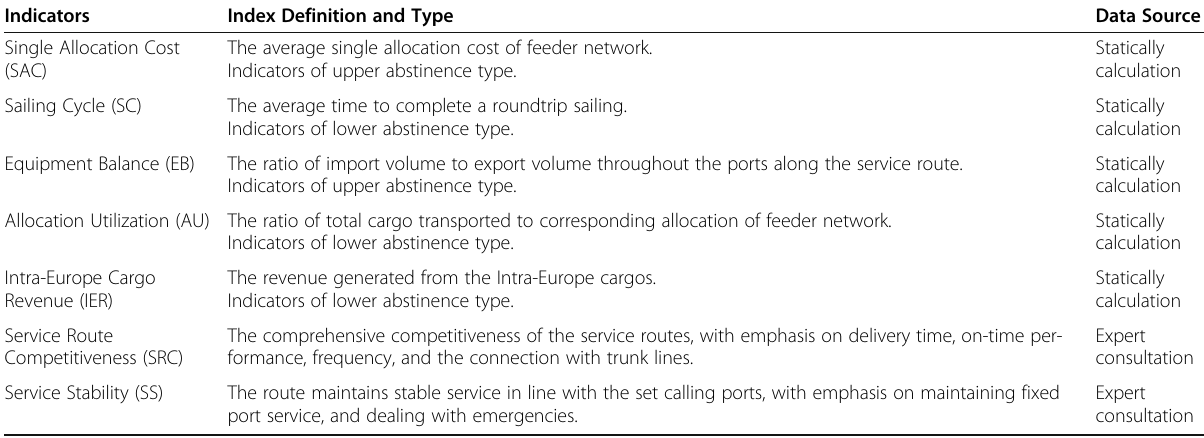
Table 11 Indicators of Feeder Network Scheme Evaluation (Source: authors) Indicators Index Definition and